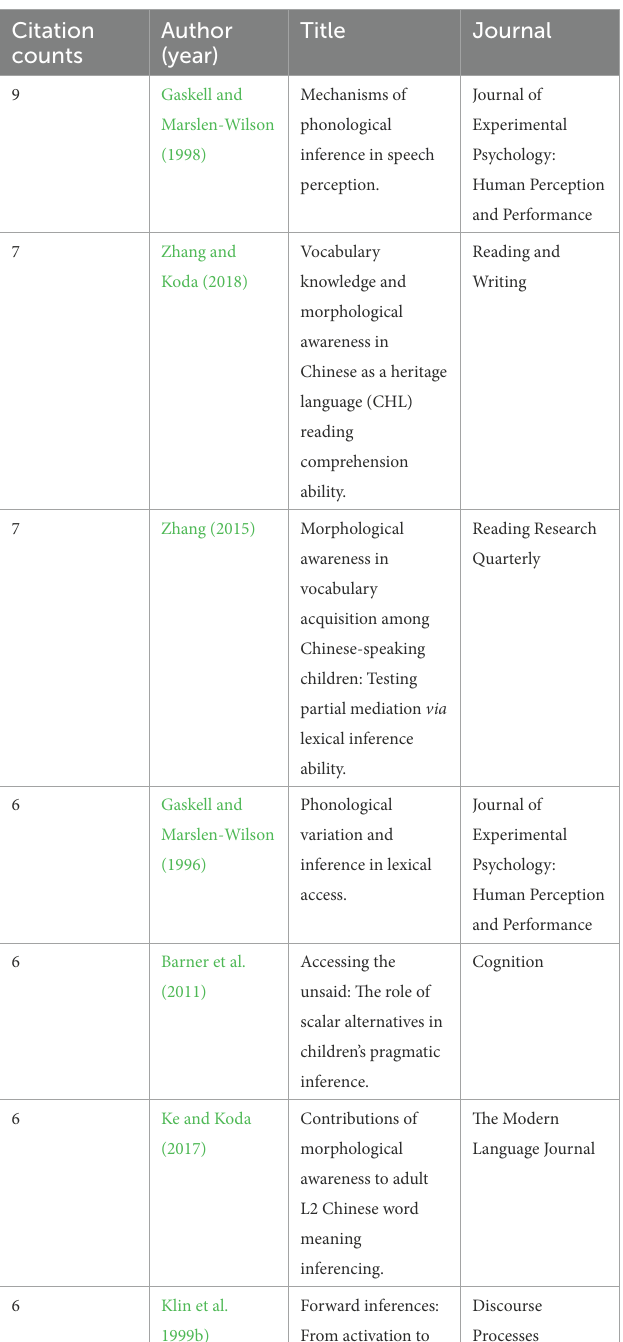
TABLE 1 The top seven most cited articles in lexical